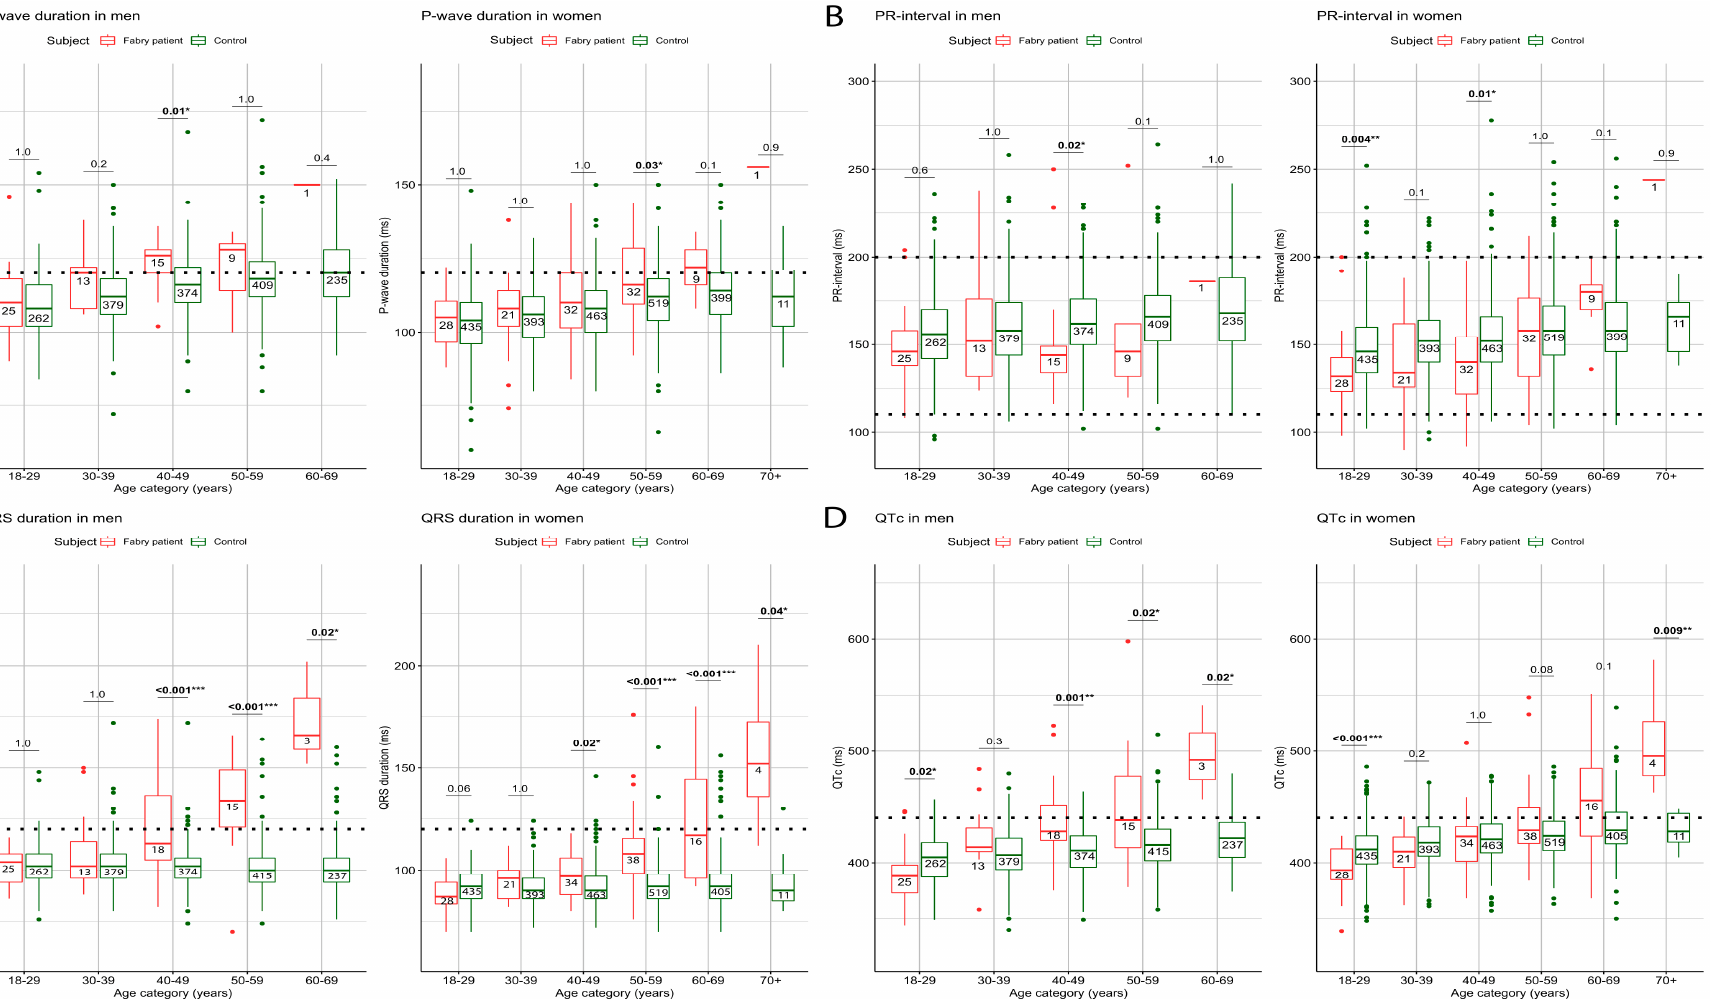
Figure 3. Boxplots of ( A ) P-wave duration, ( B ) PR-interval, ( C ) QRS-duration and ( D ) QTc per age decade in Fabry patients and controls. Numbers inside the boxes are the numbers of the analyzed ECGs. The last available ECG per FD patient per decade was selected to ensure that the influence of repeated measurements was limited. The horizontal lines represents the reference ranges of each ECG parameter, based on the literature. * p < 0.05, ** p < 0.01, *** p <